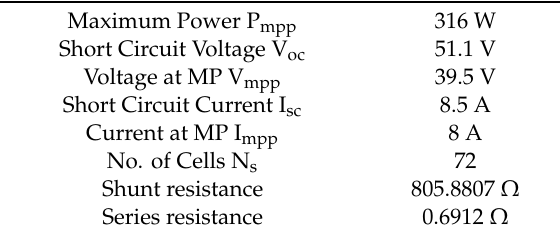
Table 1. Electrical parameters of the “Sunpreme SNPM-GX-315”.